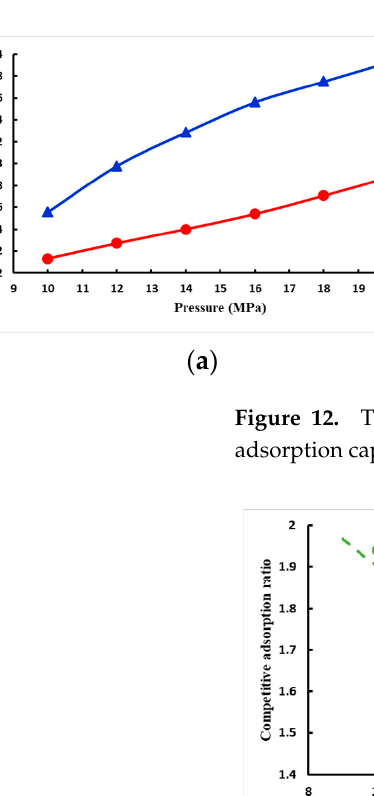
Figure 13. Competitive adsorption ratio versus pressure.